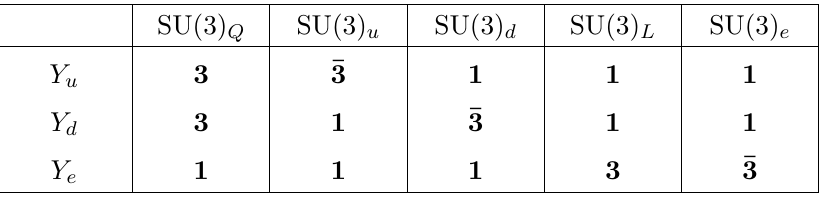
Transformation properties of the Yukawa matrices treated as spurions under the MFV